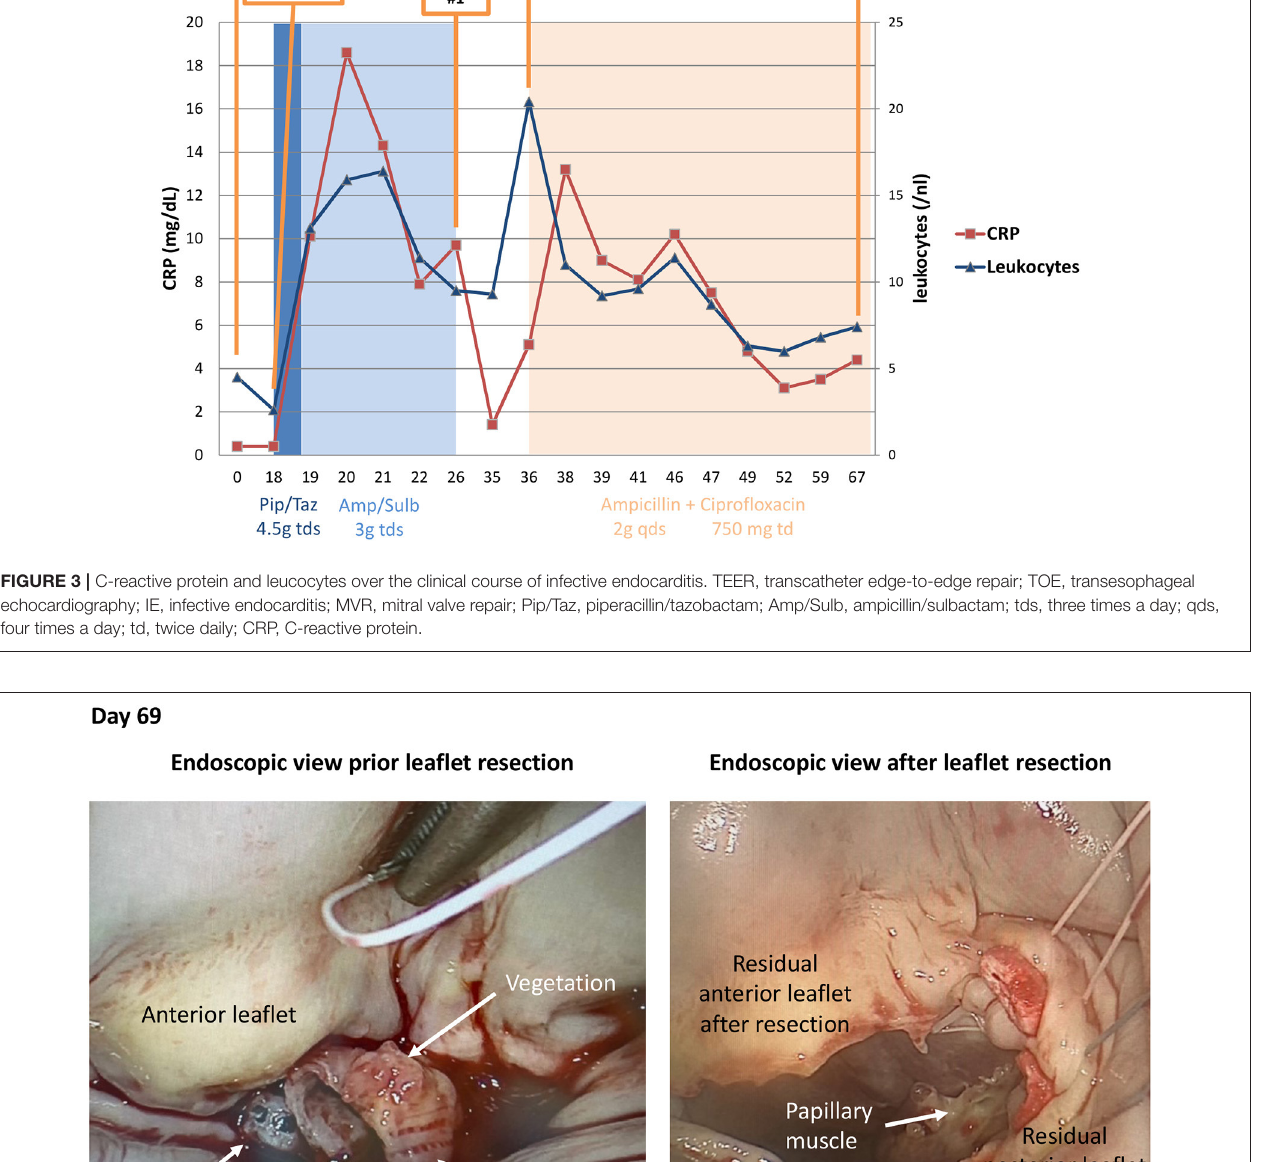
endocarditis, while microbiological culture of the resected tissue was culture negative for bacterial growth. Another four weeks of antibiotic treatment with Ampicillin 2 g qds